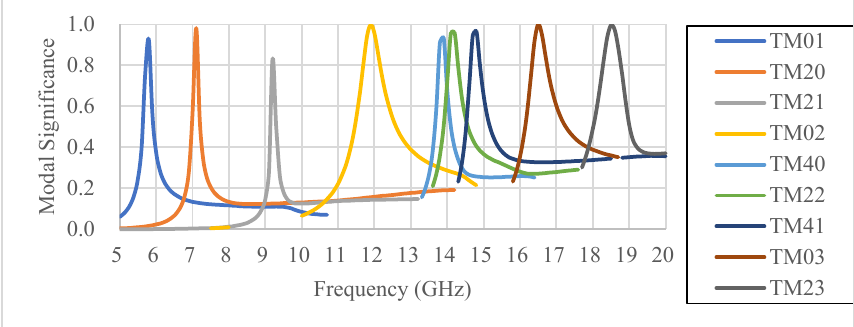
Figure 7. Modal significance of the proposed patch antenna with the slot.